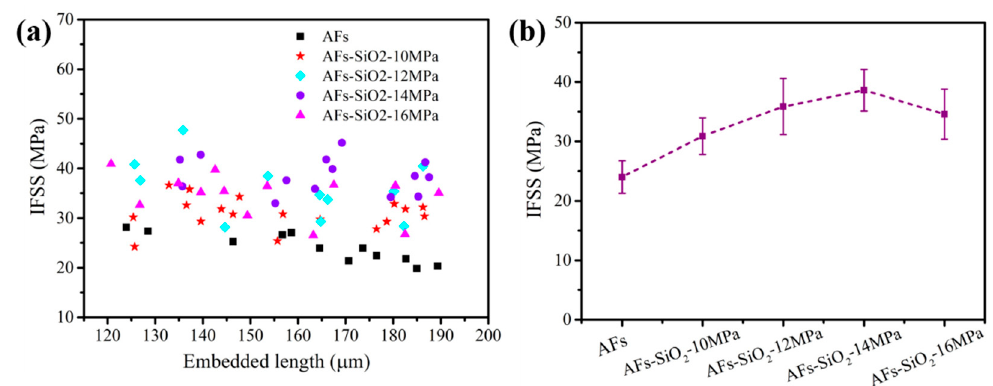
Figure 12. IFSS variation with di ff erent embedded lengths of the untreated and nano-SiO 2 modified Figure 10. IFSS variation with different embedded lengths of the untreated and nano-SiO 2 modified AF ( a ) and their values ( b AF ( a ) and their values ( b ).